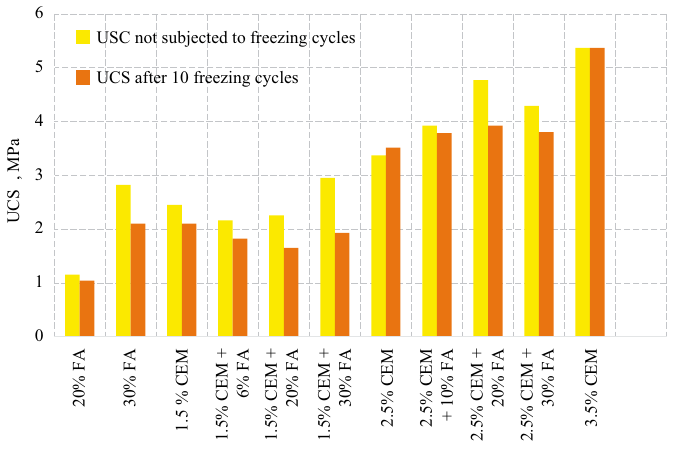
Figure 4. Unconfined compression strength for reference samples and after ten freezing cycles